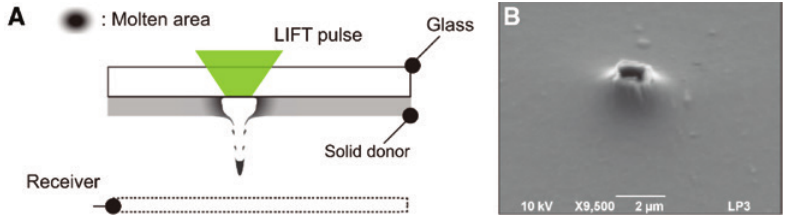
Figure 5: Schematic illustration of the thermally induced nozzle approach (A) and SEM image of a copper donor film after an ultrashort pulse irradiation showing the formation of a thermally induced nozzle (B). The laser fluence is tuned to melt almost the full film thickness, and the expansion of the heated metal forms a nozzle from which is ejected a